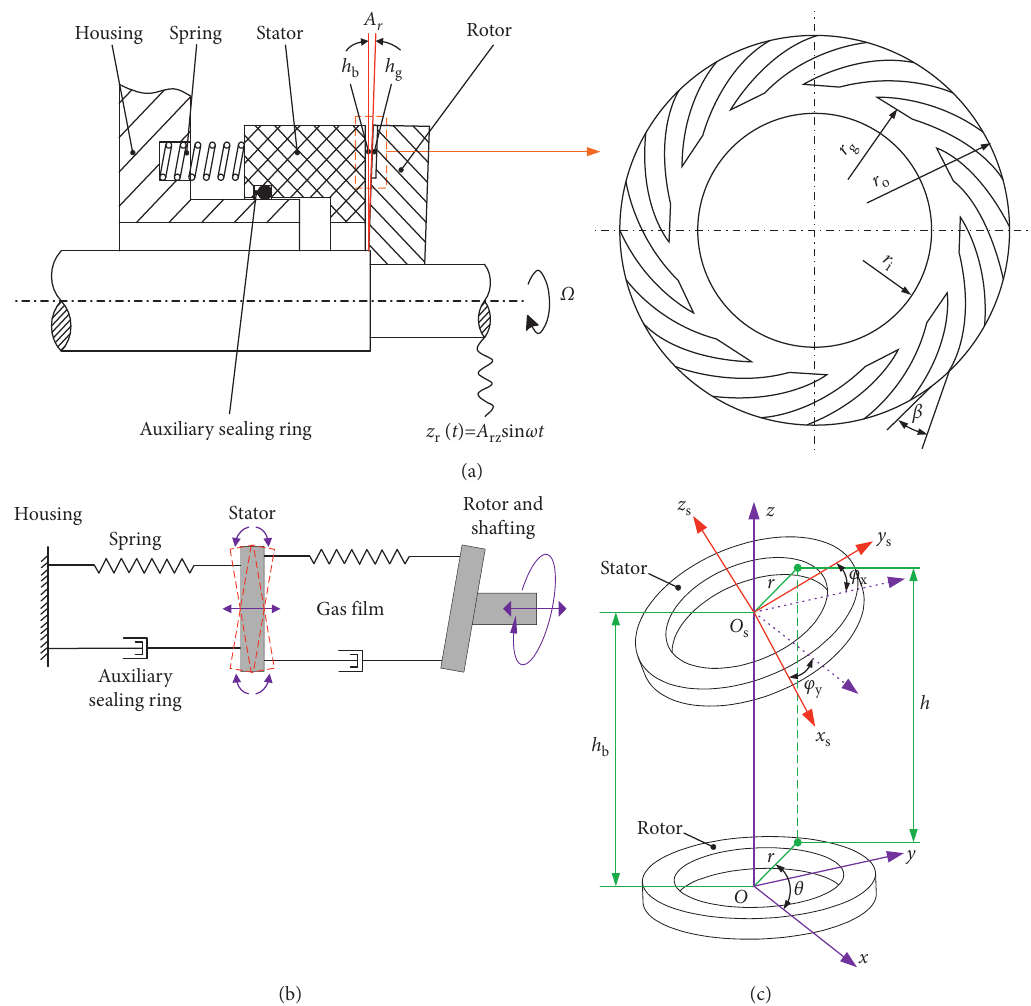
Figure 1: Schematic diagram of the geometric structure and kinematic model of the flexibly mounted stator DGS: (a) geometric structure model; (b) kinematic model and (c) positional